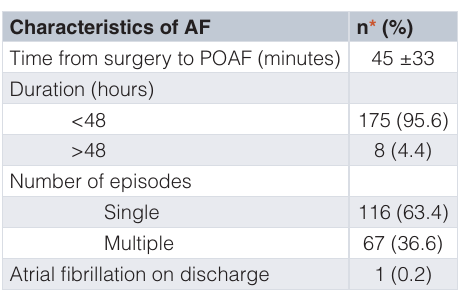
Table 2. Characteristics of post-operative atrial fibrillation